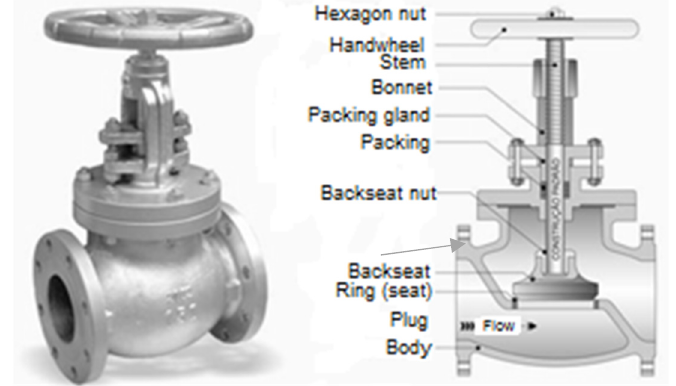
Figure 2. Globe valve [6].